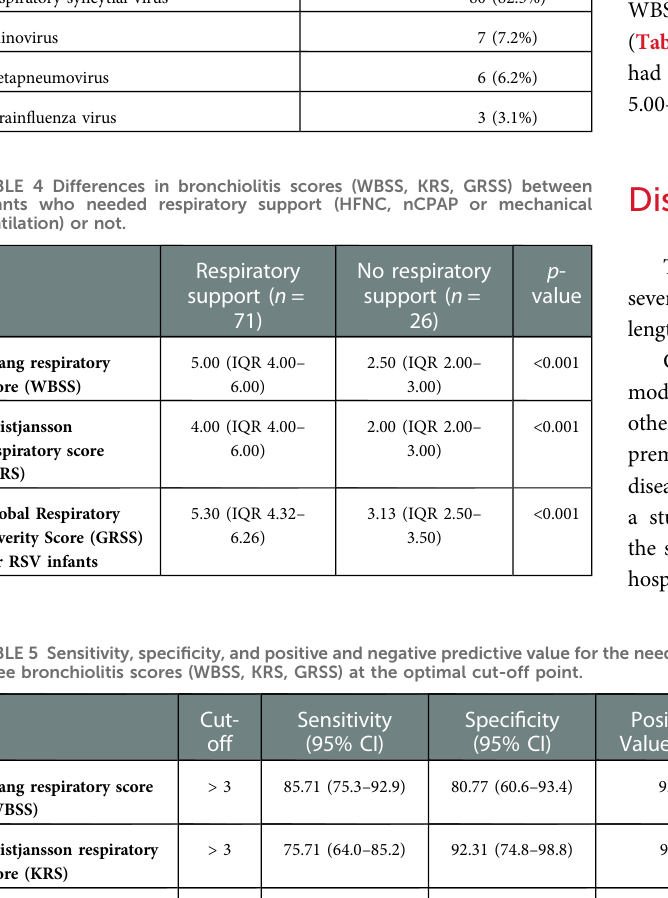
( Table 6 ). The three infants who required mechanical ventilation